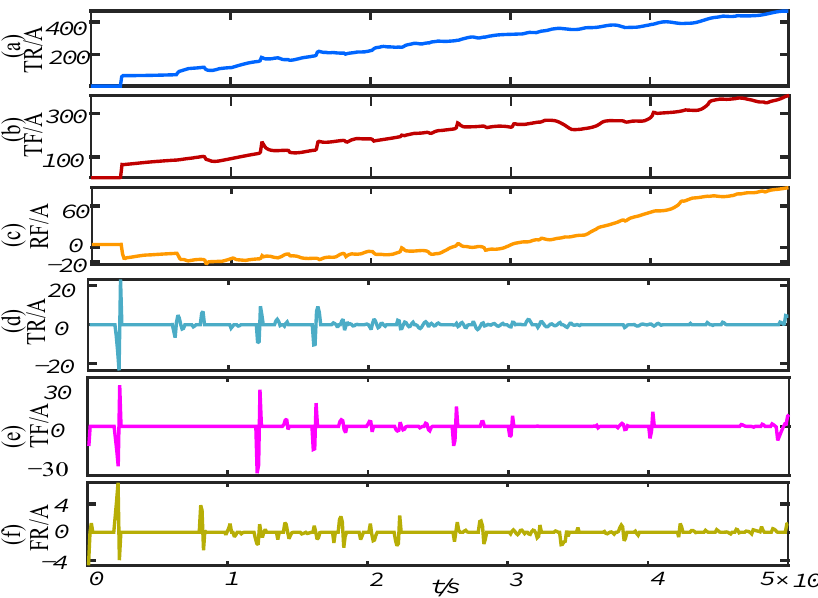
Figure 14. Short circuit fault signal before and after improved HHT.